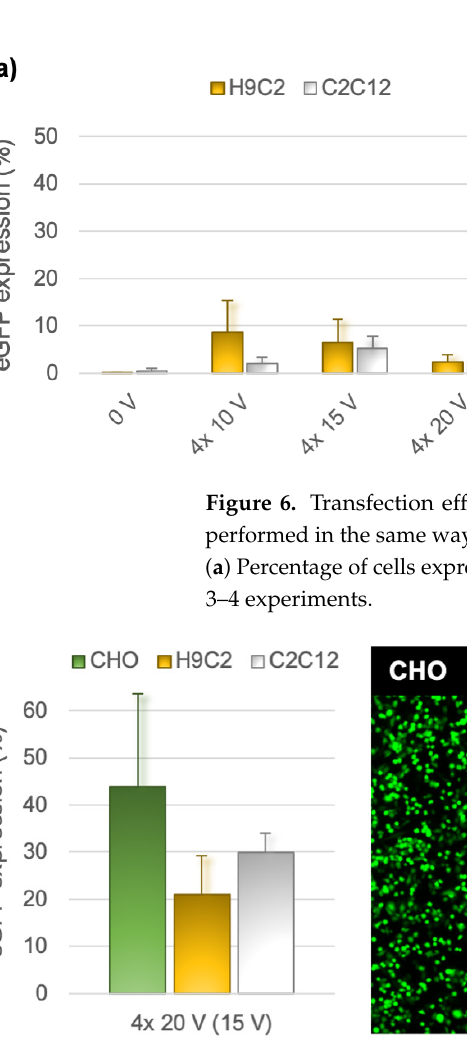
Figure 7. eGFP expression in CHO, H9C2, and C2C12 cell lines using higher plasmid concentration of 500 µg/mL. Transfection was performed with four 10-ms-long pulses with optimized voltages of 20 V (CHO) and 15 V (H9C2 and C2C12). Graph shows mean ± s.d. from 3–4 experiments. The